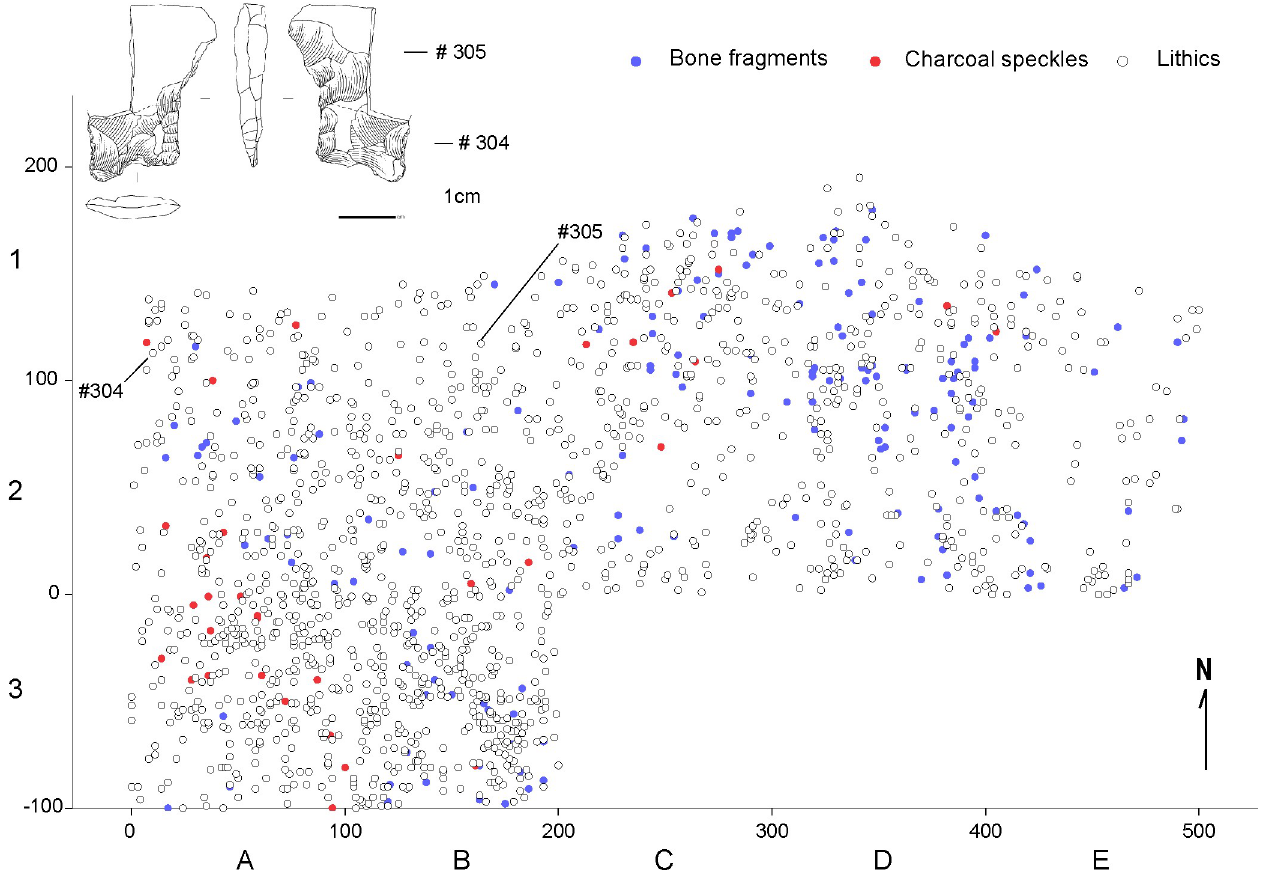
Fig 6. Spatial distribution of archaeological material between 12,690–12,550 cal BP. Considers piece plotted specimens between 52 and 82 cm; X and Y axis are in cm.